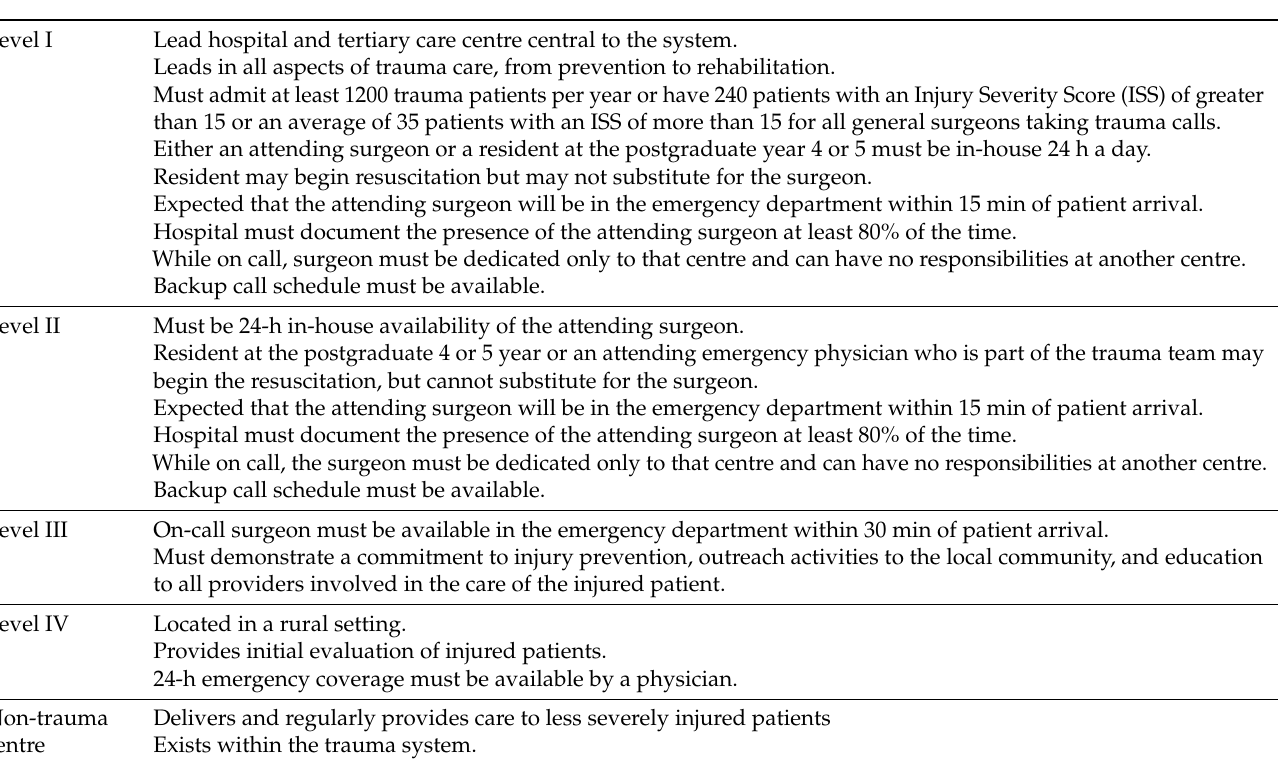
Table 3. The ACS COT trauma centre